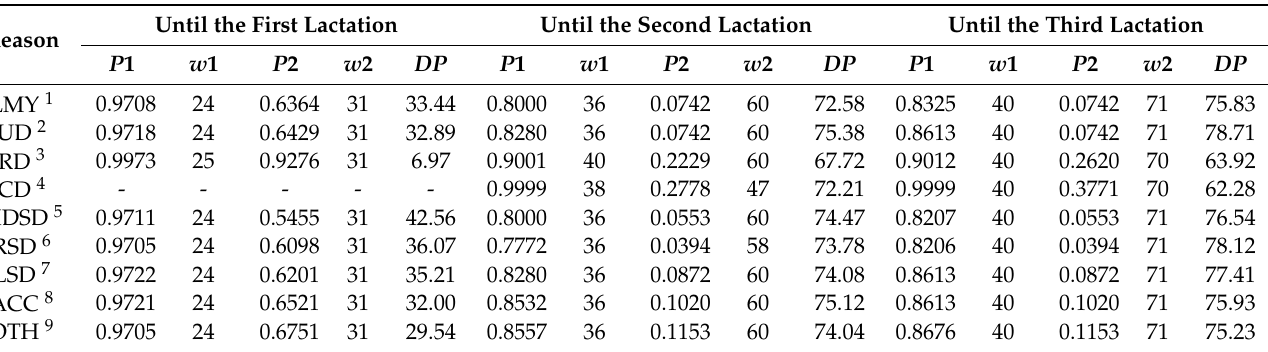
Table 2. Cumulative proportions of cows surviving ( P1 and P2 ) until the age interval ( w1 and w2 ) and the percentage decrease ( DP ).